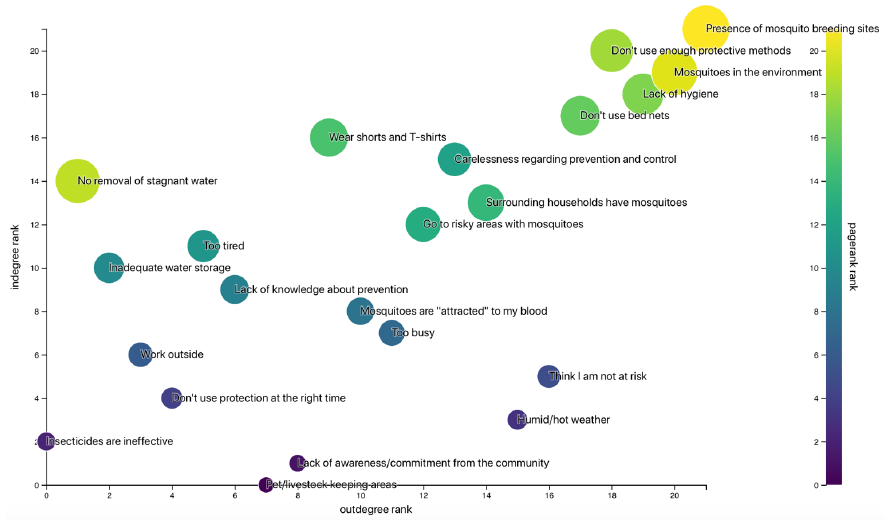
Figure 2. Ranking of determinants by in- and outdegree. Circles are sized according to the PageRank value of each factor. value of each